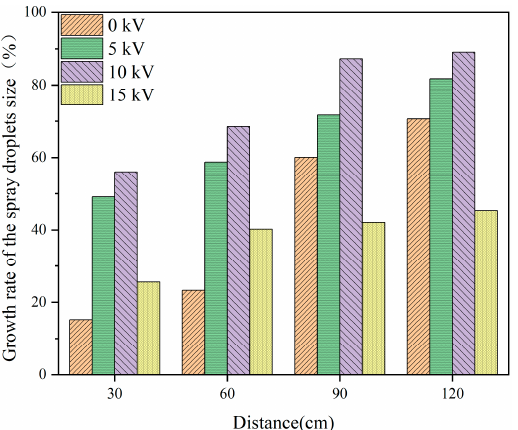
Figure 5. The water mist-induced charged atomization mechanism.